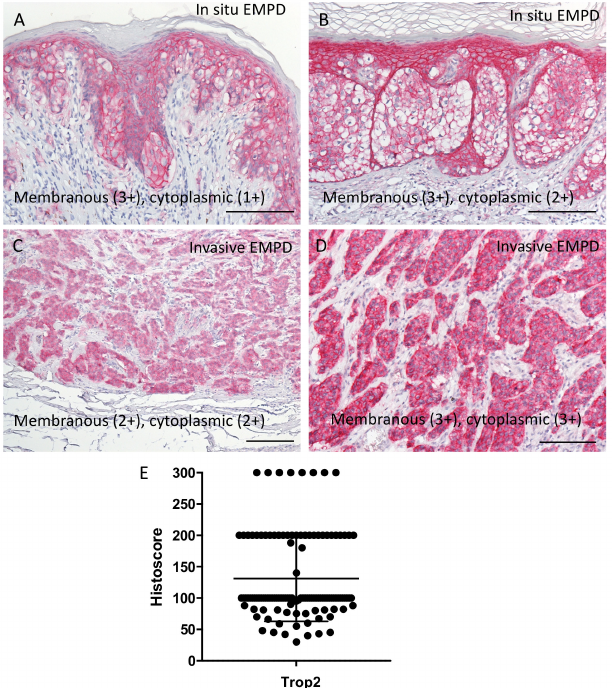
Figure 3. ( A – D ) Other histopathological images of Trop2 staining. In situ ( A , B ) and invasive ( C , D ) EMPD. Staining patters were variable. Cytoplasmic staining was observed in most EMPD tissues with or without membranous staining. Cytoplasmic staining was obscure in some mucin-rich cells ( B ). ( E ) Histoscores of Trop2 staining. All EMPD tissues had positive Trop2 staining in at least some areas. Bars indicate 100 µ m. Trop2, trophoblast cell surface antigen 2; EMPD, extramammary Paget’s